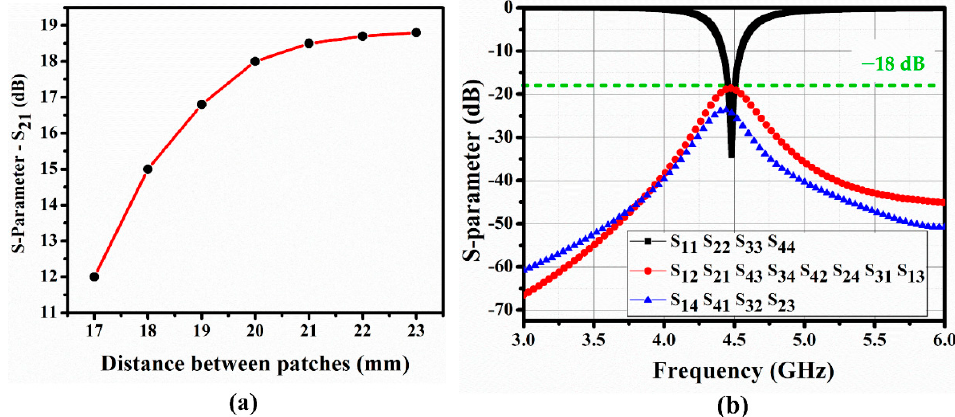
Figure 2. ( a ) Simulated isolation between ports 1 and 2 (S 21 ) for different distances, a, between quarter ‐ mode substrate ‐ integrated waveguide (QMSIW) segments (see Figure 1), and ( b ) S ‐ parameters for 4 ‐ port QMSIW at b = 20 mm.